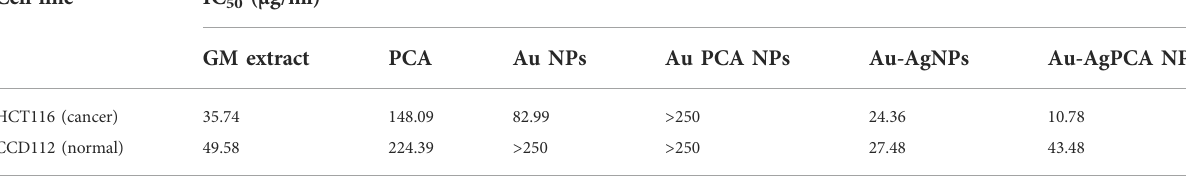
TABLE 4 IC 50 values of mangosteen extract, protocatechuic acid, and nanoparticles against two cell lines. Cell